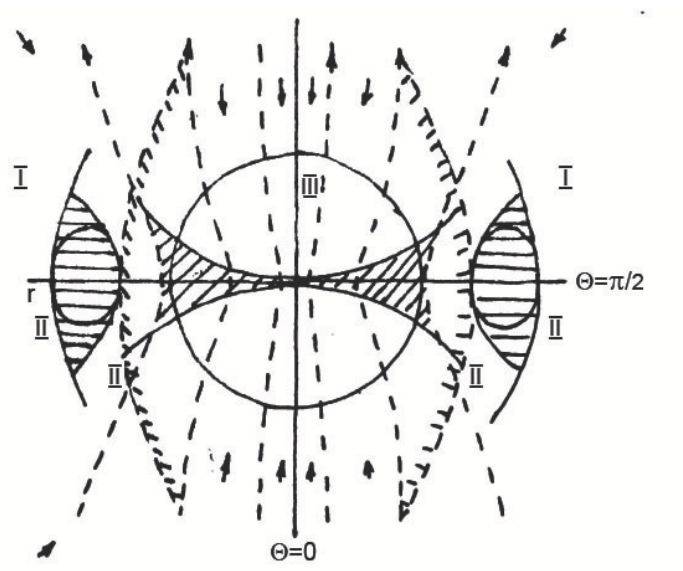
Figure 1. Three zones around a black hole (BH) during accretion of a gas with a frozen magnetic field, homogeneous at infinity. (I) A zone of the stationary hydrodynamic flow with a non-stationary magnetic field. (II) A zone of the stationary flow in which the transition from the subsonic to the supersonic flow takes place. (Ill) A zone of the stationary supersonic flow. Dashed line marks a place where the velocity reaches the critical sound value. At the plane perpendicular to the magnetic field direction at infinity, thin disk forms around a BH. In zone II the disk becomes thicker and merges with the surrounding flow. Arrows in the direction of the flow velocity have opposite signs in the lower and upper parts, the magnetic field has the same direction there. The ring-like stagnation zone formed in the subsonic region of the stationary flow and situated around the symmetry plane is shown by the horizontal strokes. The sizes of two inner zones are slowly increasing with time, see Reference